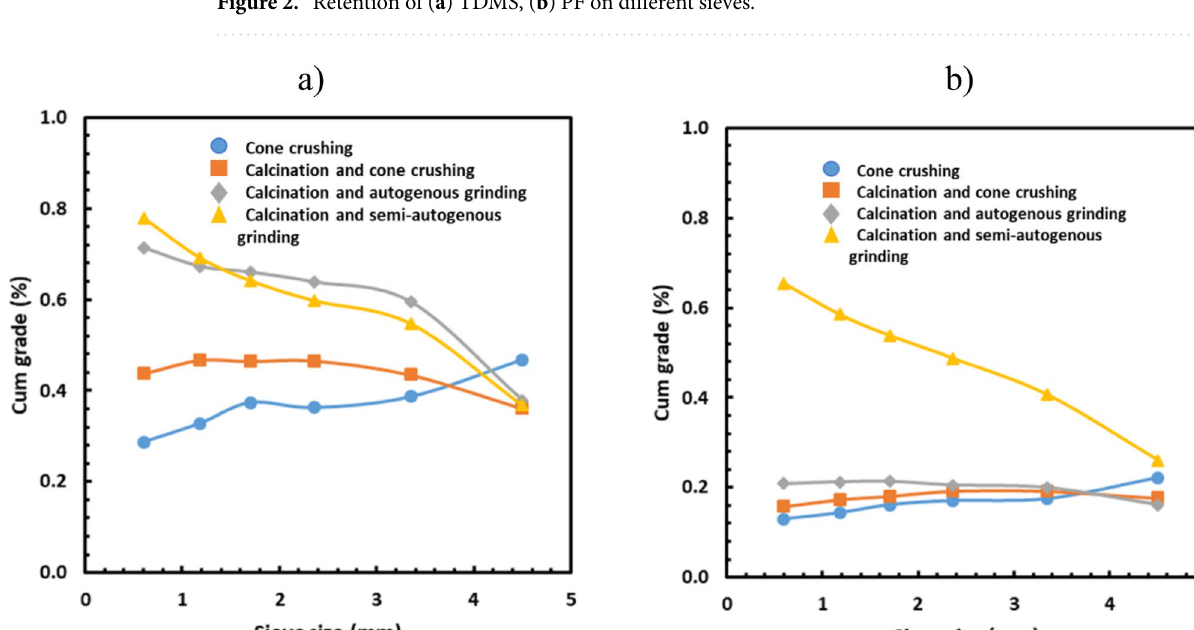
Figure 3. Influence of calcination and comminution methods on cumulative grade of lithium in the case of ( a ) TDMS and ( b )